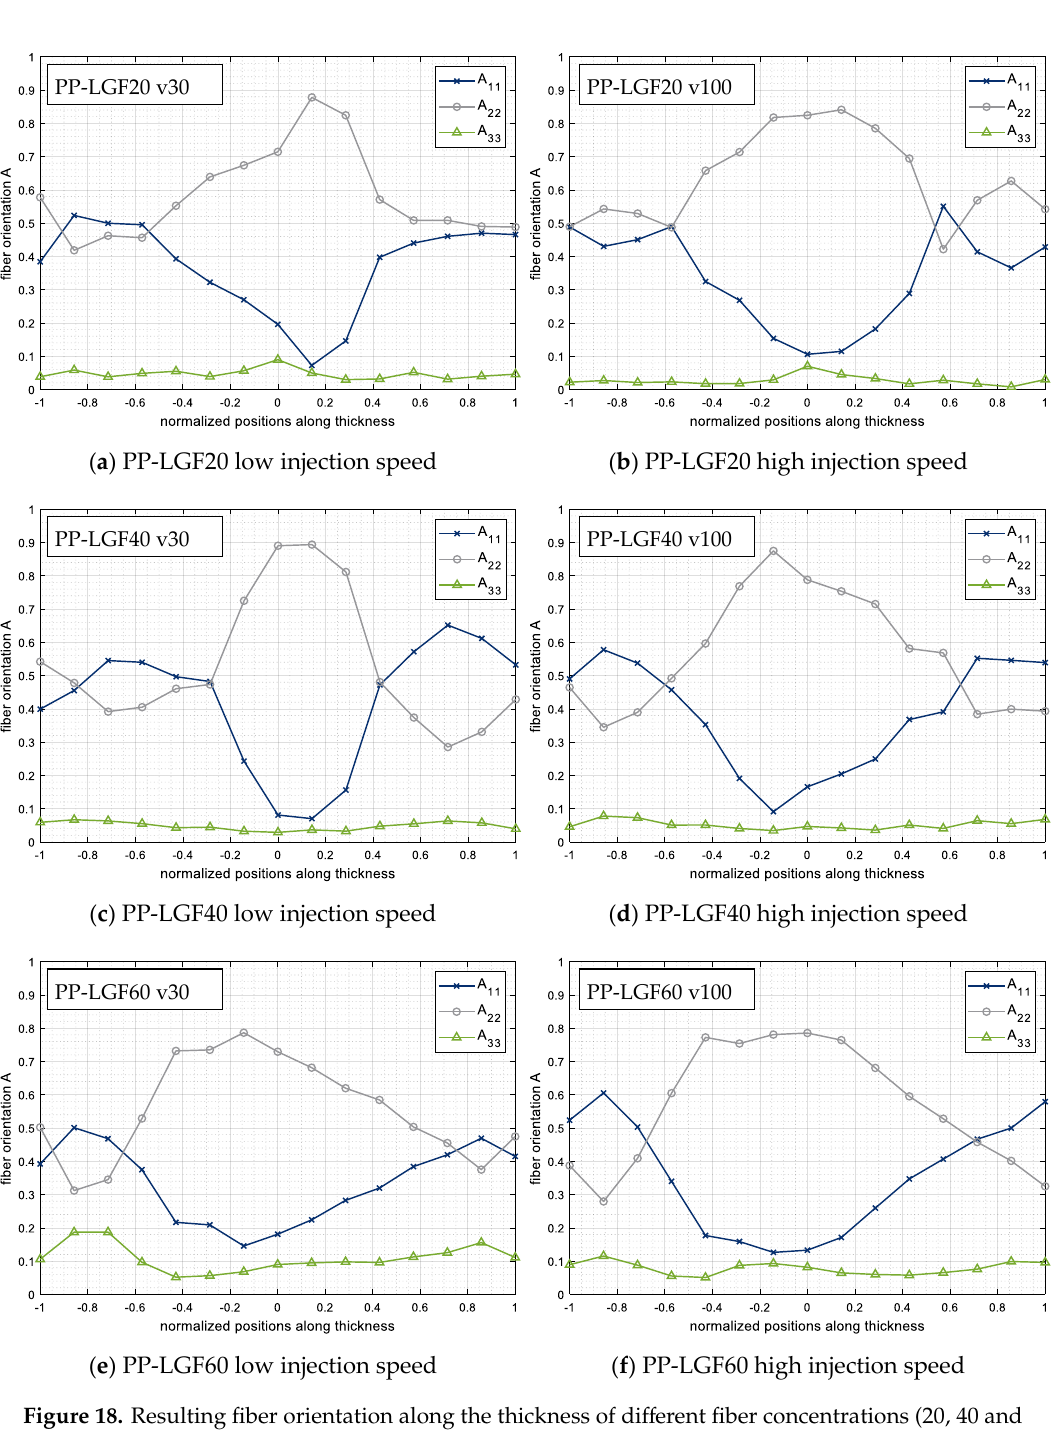
Figure 18. Resulting fiber orientation along the thickness of different fiber concentrations (20, 40 and 60% mass fraction long glass fiber) and different injection speeds (low = 30 cm 3 /s, high = 100 cm 3 /s).